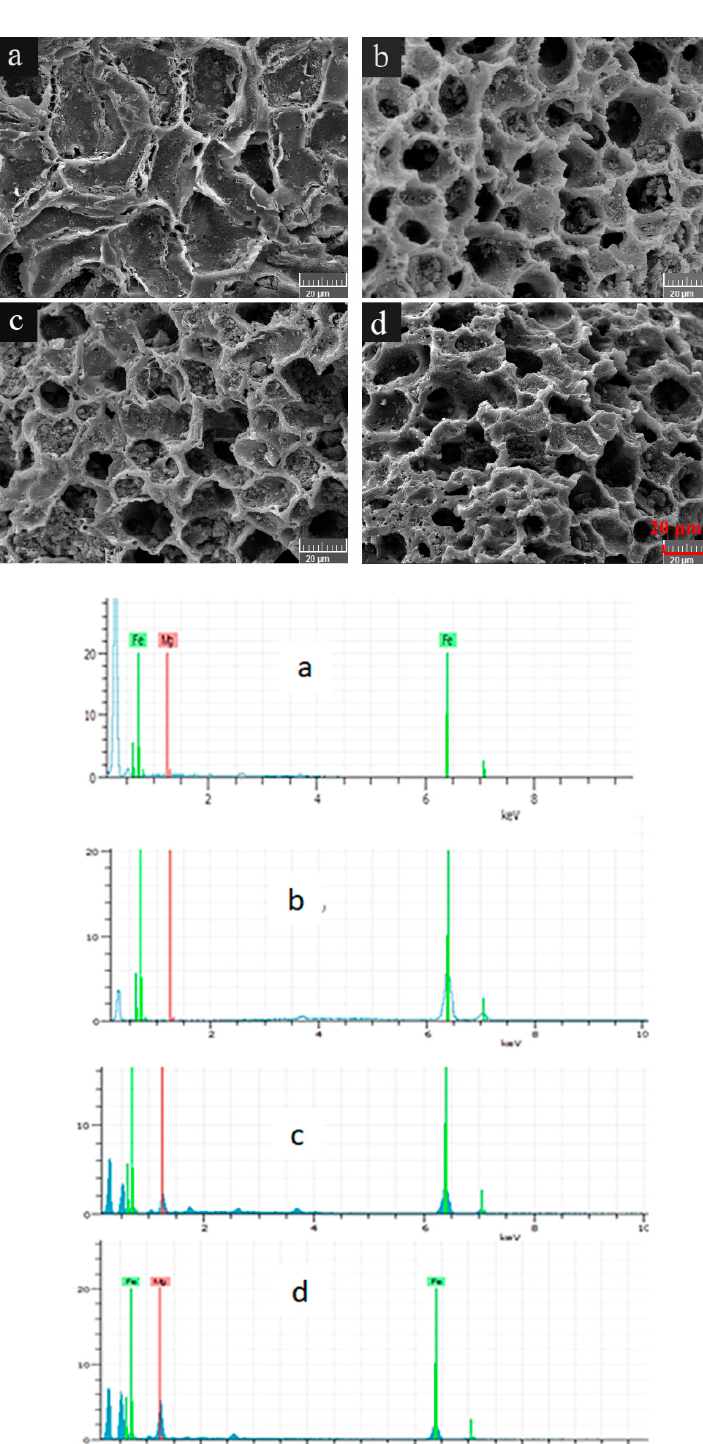
Figure 1. Morphological structures of WBC and WBC1x. ( a ) WBC, ( b ) WBC10, ( c ) WBC11 and ( d ) WBC12.